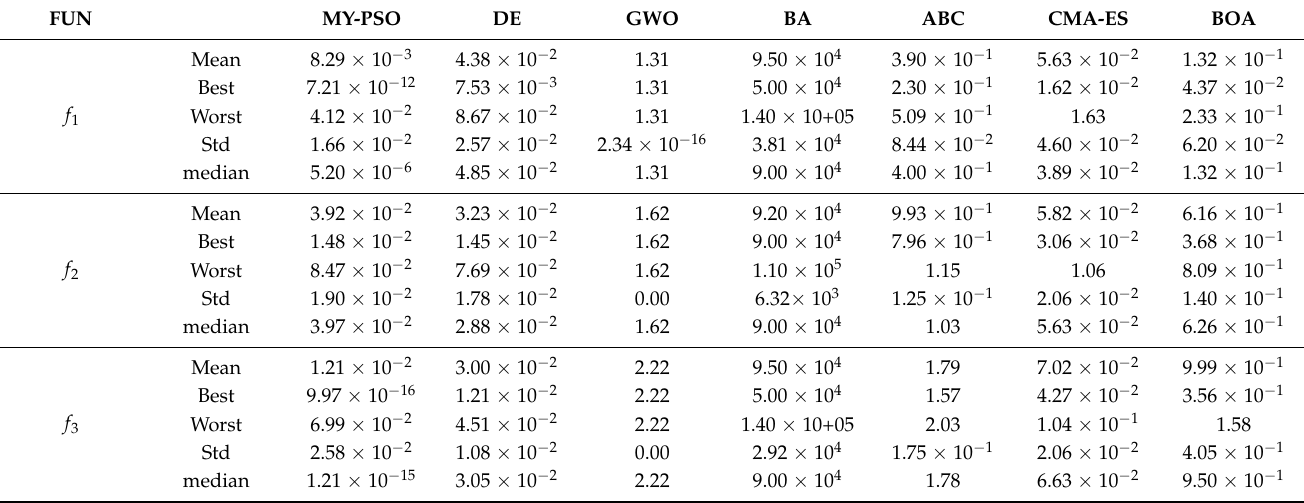
Table 4. Comparisons of experimental results between SHPC and meta-heuristic algorithms.